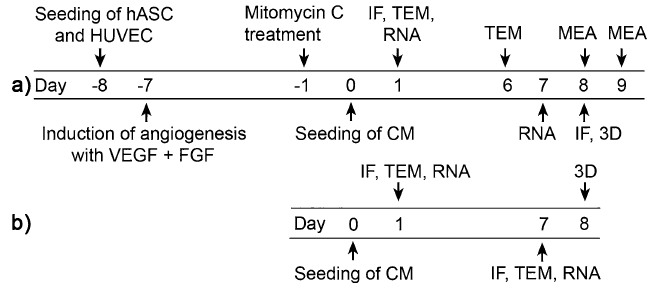
Figure 1. Cell culturing procedure. Cell culturing procedure for ( a ) the cardiac tissue model and ( b ) the cardiomyocyte monoculture. Time points for immunofluorescence (IF), immunofluorescence 3D images (3D), transmission electron microscopy (TEM), gene expression analyses (RNA) and electrophysiological measurements